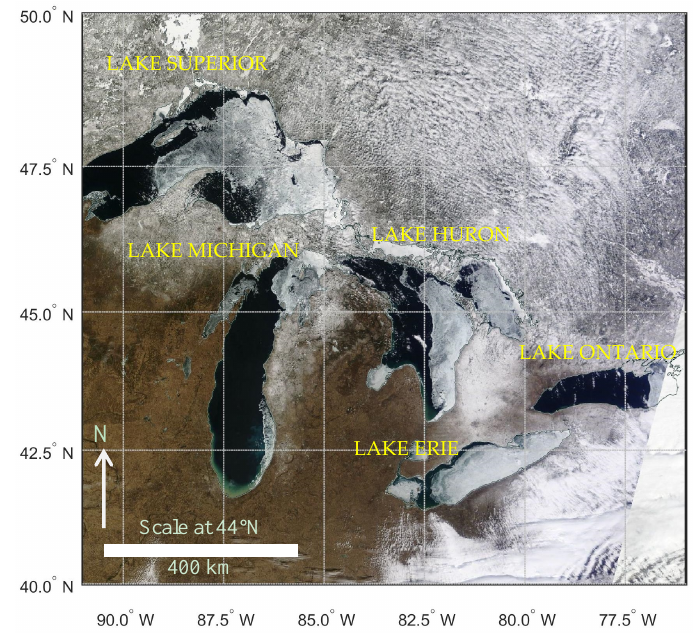
Figure 1. Ice cover on the Great Lakes. Image acquired on 17 March 2015 (NASA).